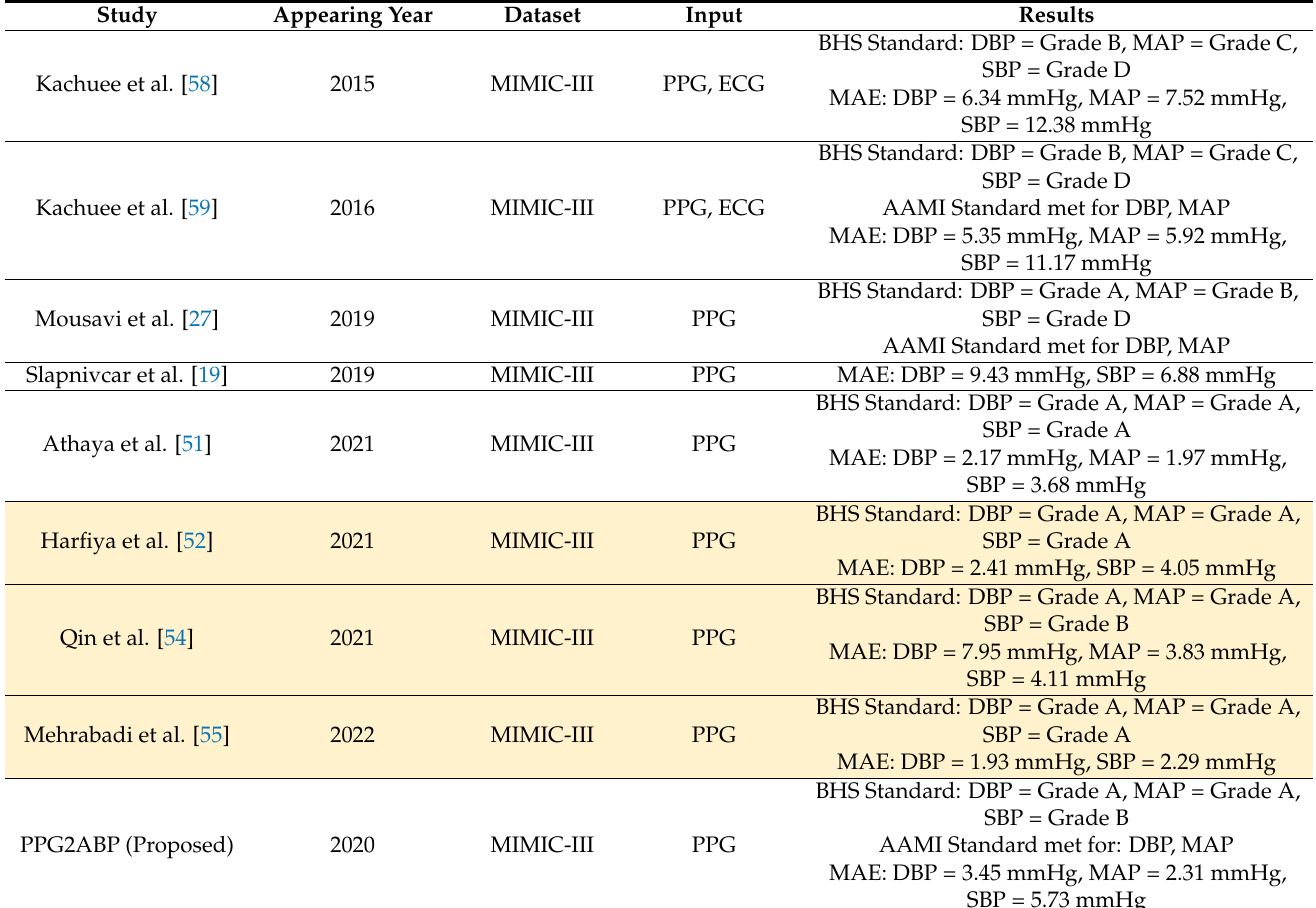
Table 4. Comparison among different approaches. Here, we list the methods that used the MIMIC-III dataset to evaluate their performance. Furthermore, for a fairer comparison, we have only included the methods that consider a significant portion of the dataset. We compare the methods using measures such as Mean Absolute Error (MAE) for predicting DBP, MAP, and SBP, in addition to BHS and AAMI